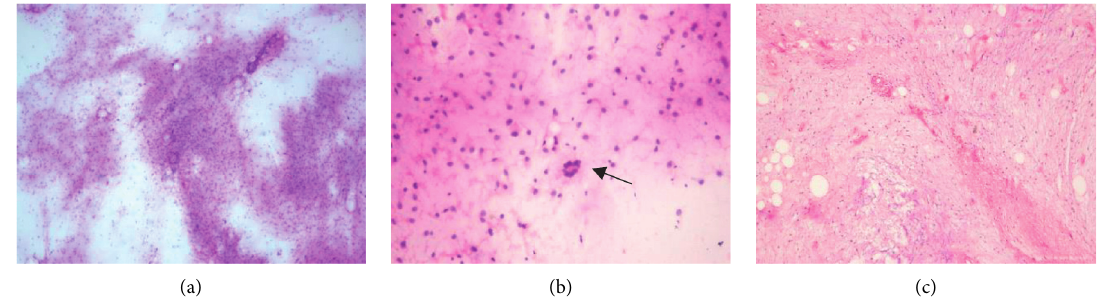
Figure 2: Myxoid liposarcoma. (a) Case diagnosed as atypical lipomatous tumor on scrape smear showing fragments of fibroadipose tissue and atypical cells (H&E, X100). (b) Scrape smear showing round to oval shaped tumor cells showing mild atypia. Note floret cell is seen (arrow) (H&E, X400). (c) Section showing spindle-shaped cells with hyperchromatic nuclei along with mature adipocytes. Background showing myxoid matrix (H&E, X100).